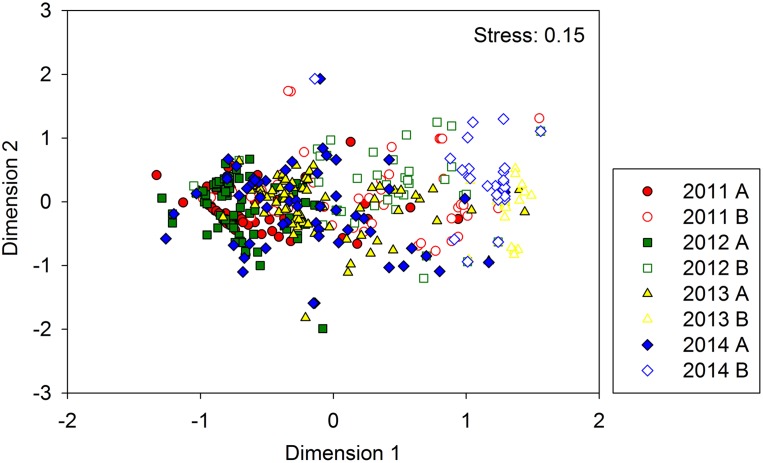
nMDS ordination showing differences in benthic assemblages (fish and crustaceans) found at the study area (Zones A and B) during the four year study period.Data were Log (x + 1) transformed.